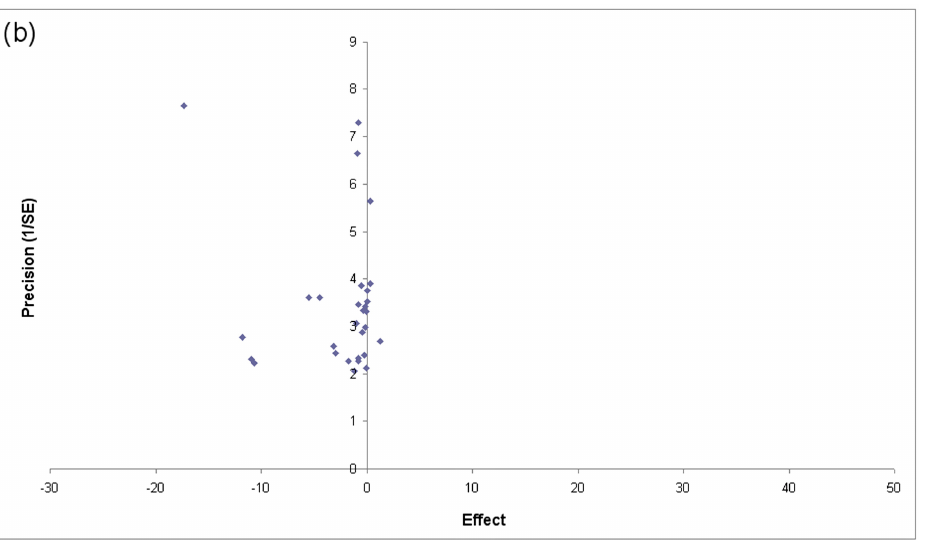
Figure 4. ( a ) Funnel plot for meta-analysis related to serum Zn; ( b ) Funnel plot for meta-analysis related to plasma Zn.